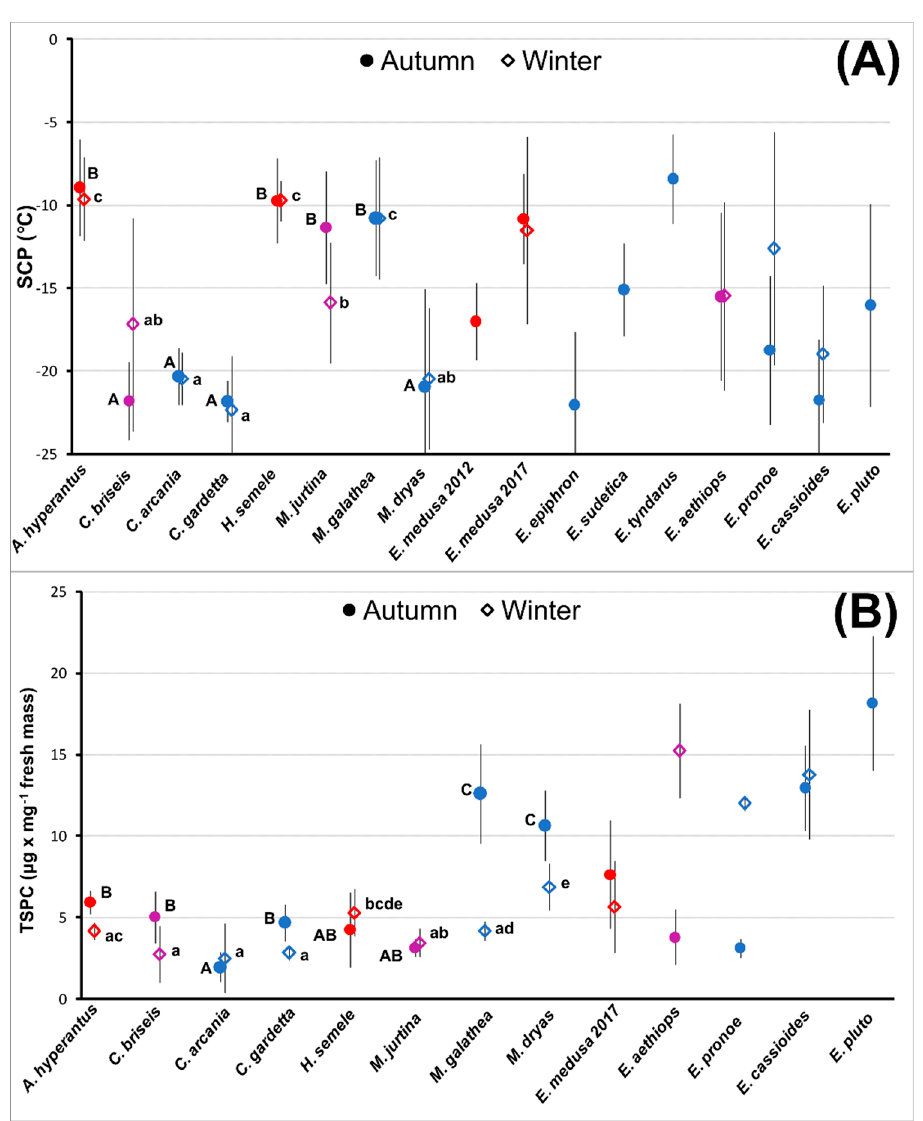
Figure 1. Overview of supercooling points, SCP ( A ), and total sugars and polyols concentrations, TSPC ( B ), found for the eight Satyrinae species assayed for this study, and the eight Erebia spp. assayed in [14,15]. Filled circles stand for Autumn, and empty diamonds for Winter treatments. The letters accompanying the marks denote significant differences among species and treatments, as revealed for the eight newly assayed Satyrinae species by Tukey’s HSD test (Supplementary Table S2). Color codes: freeze ‐ avoidant species are blue, freeze ‐ tolerant species red, mixed ‐ strategy species violet.